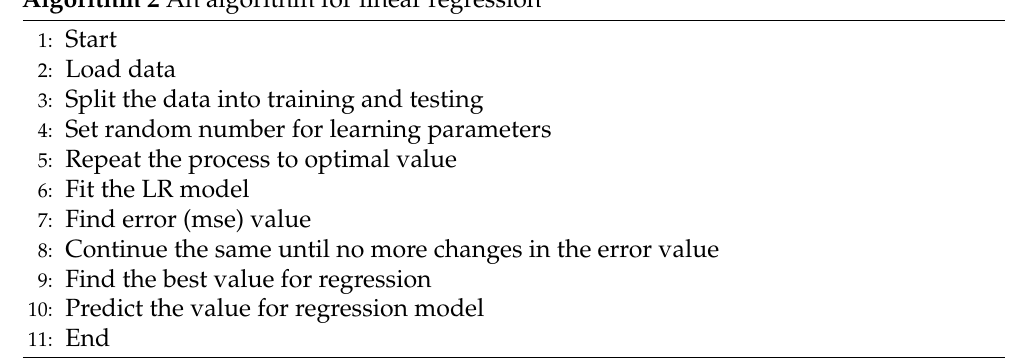
Algorithm 2 An algorithm for linear